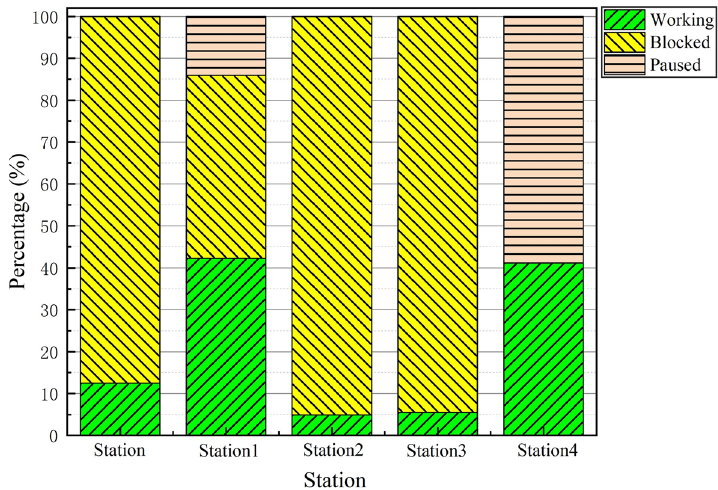
Fig. 9 Work at workstation beforeoptimization